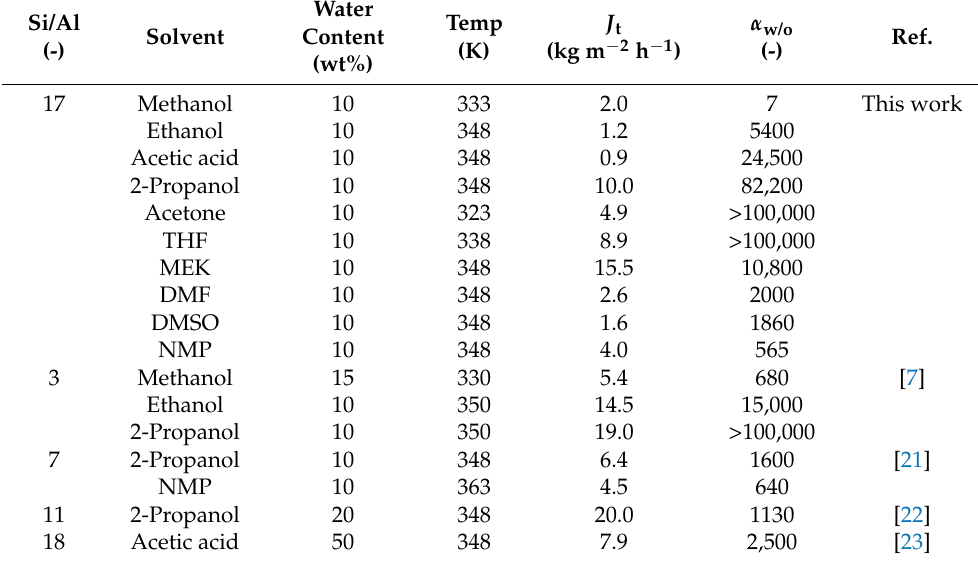
Table 2. Dehydration performances of the CHA-type zeolite membrane for several organic solvents. Water Si/Al Solvent Content (-) (wt%)